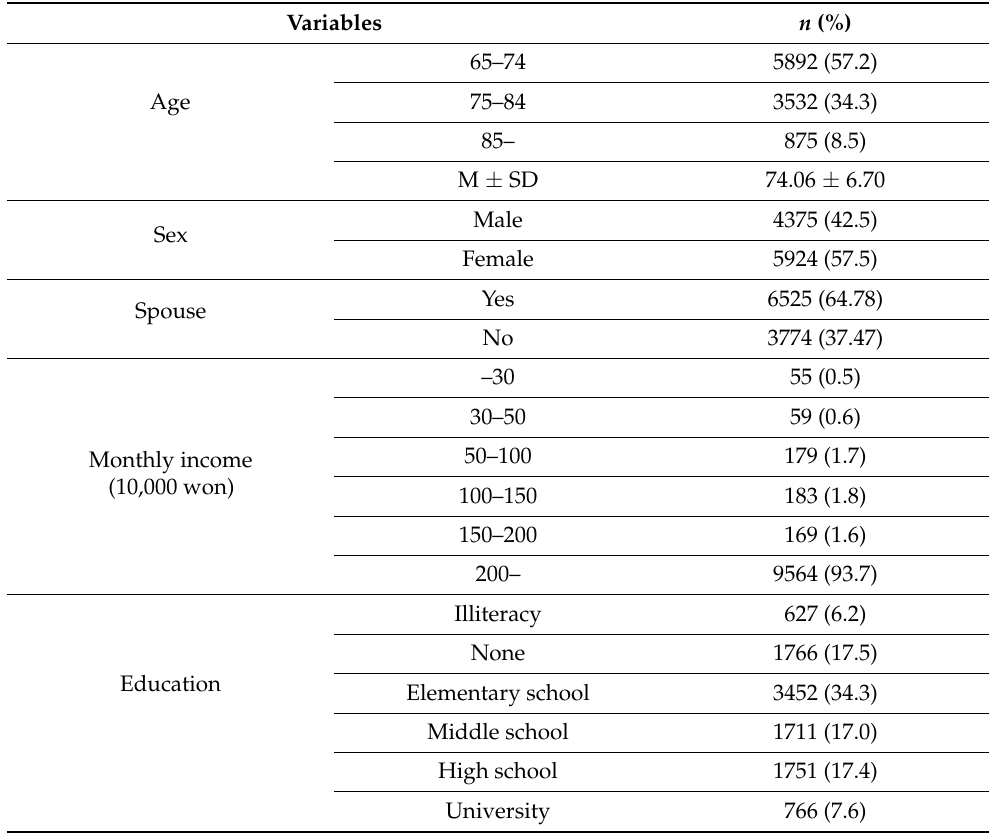
Table 1. Sociodemographic characteristics ( n = 10,073).